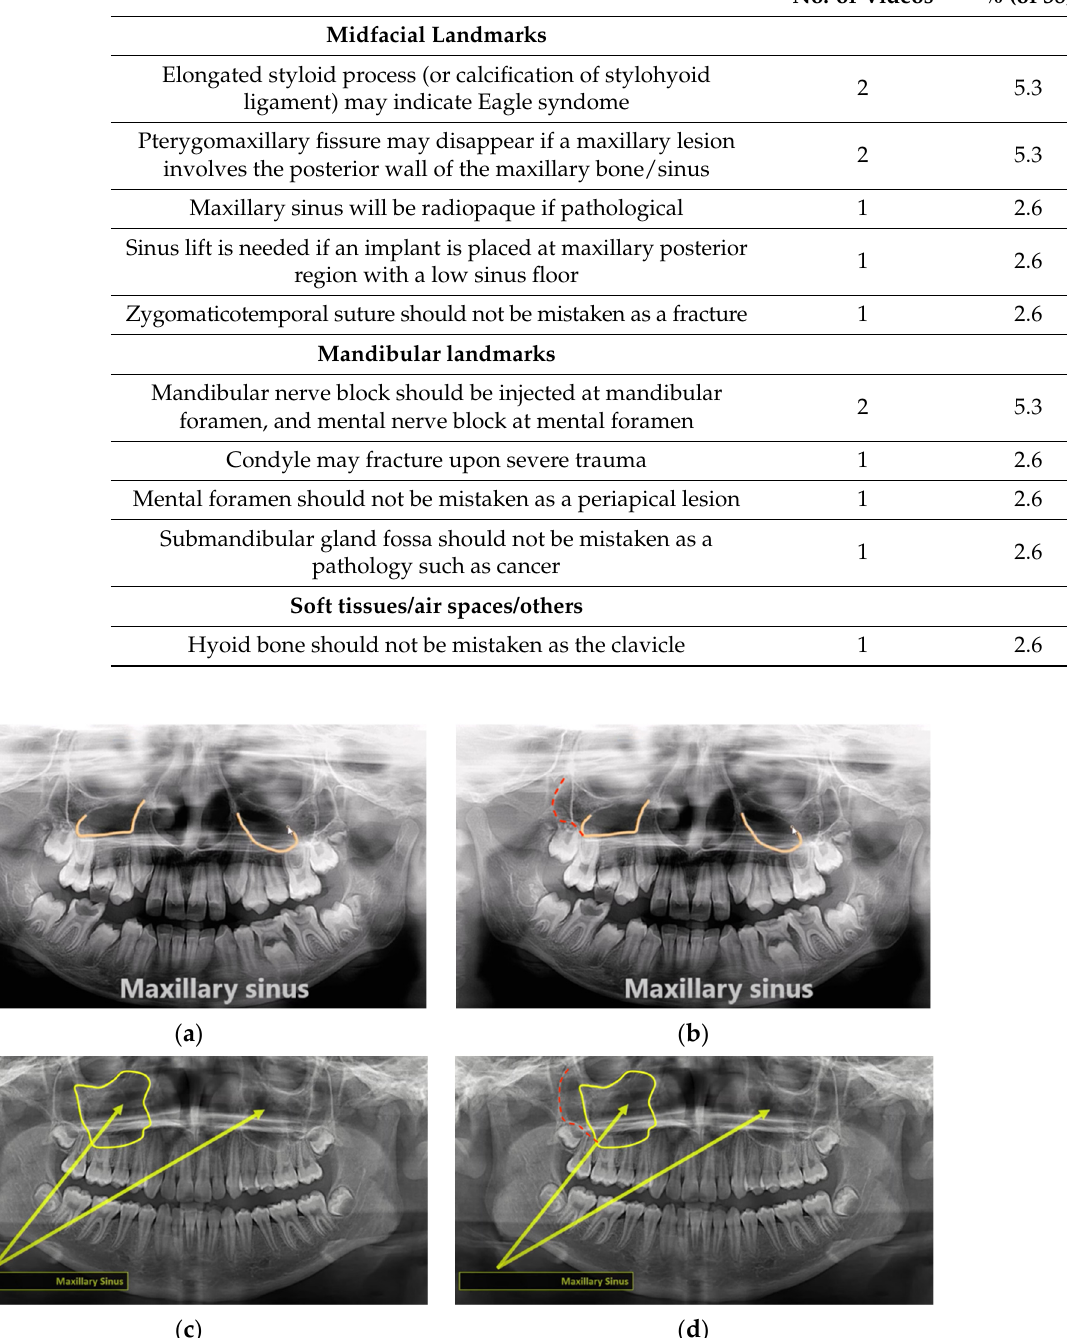
Table 4. Number of anatomical landmarks described by the 38 videos. Type